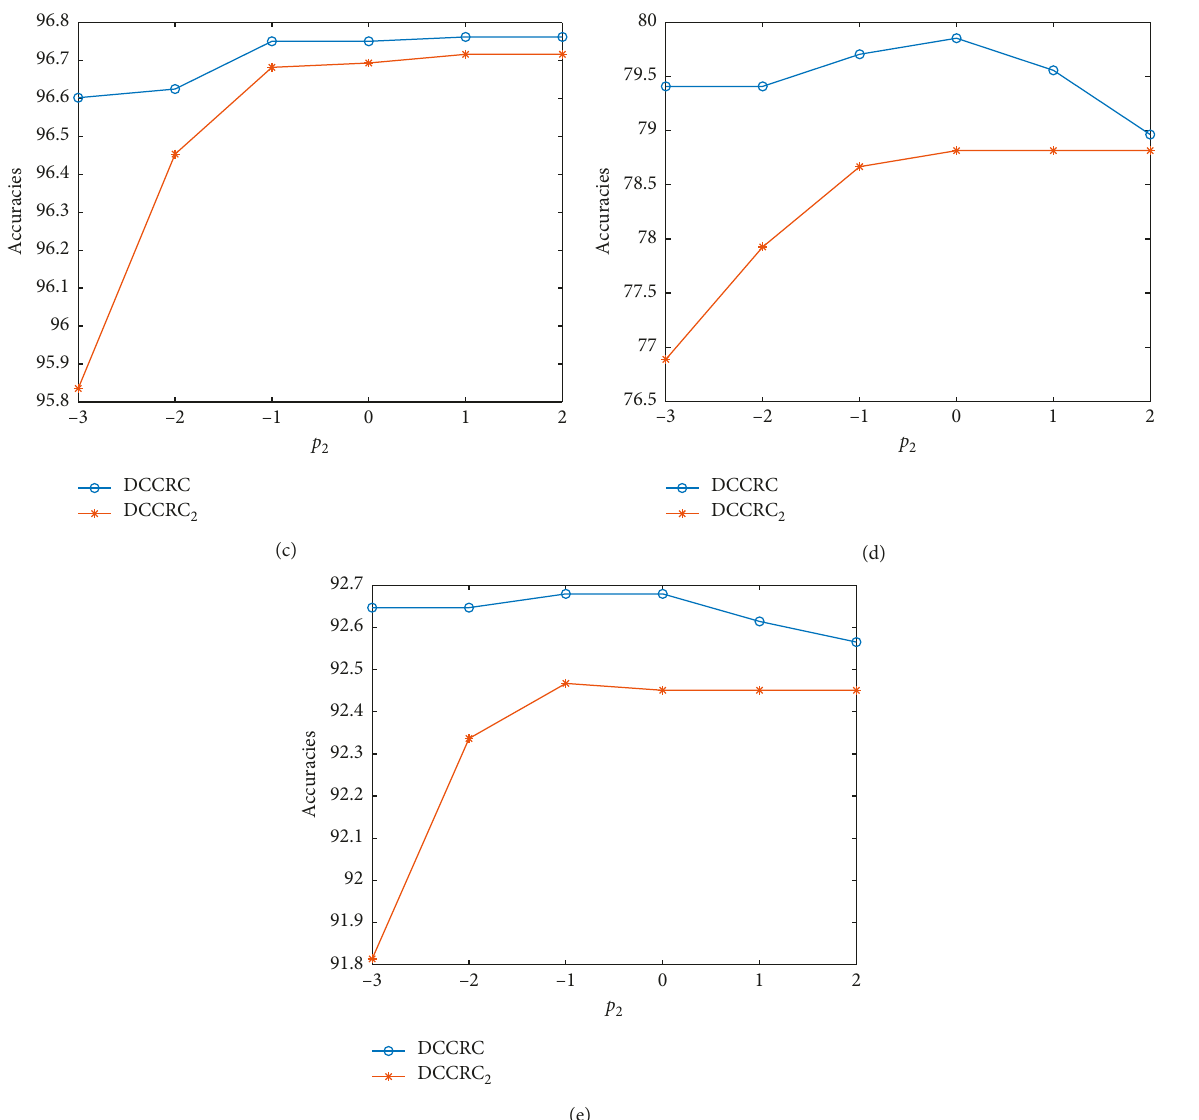
Figure 3: The comparisons of DCCRC and DCCRC ( l � 4). (c) YaleB ( l � 18). (d) Yale ( l � 2). (e) PIE29 ( l � 6).